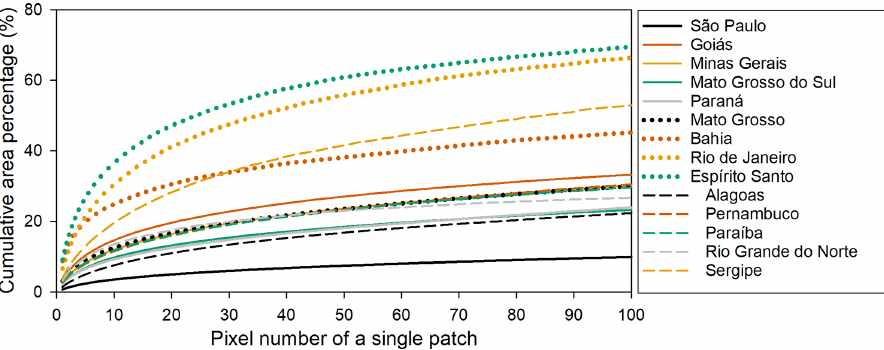
Figure 14. Statistics for patches with different pixel numbers in the sugarcane harvest map for the 14 states in Brazil in